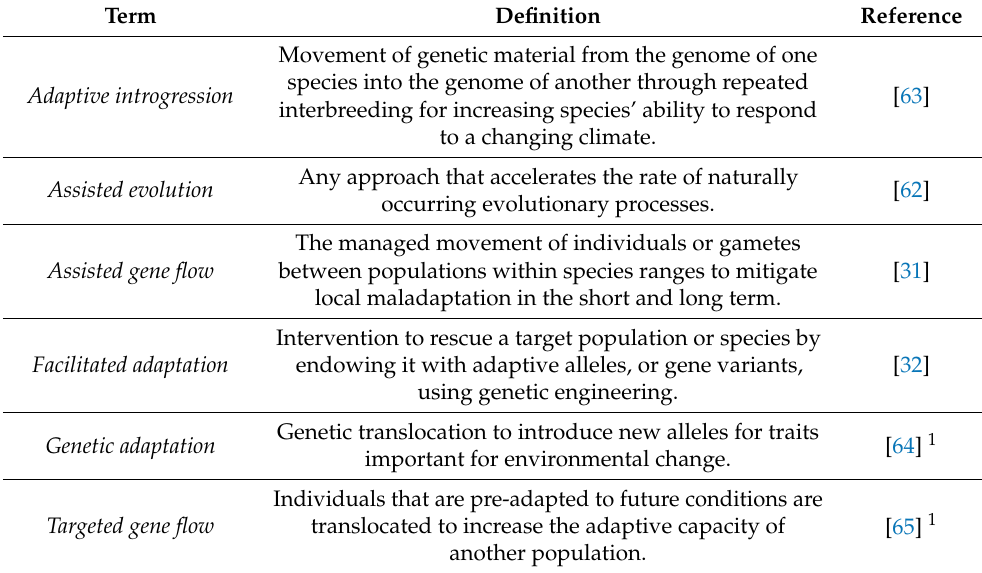
Table 1. Terms and definitions found in the literature to describe the introduction of beneficial alleles in a population to promote the evolutionary adaptation to climate change. Term